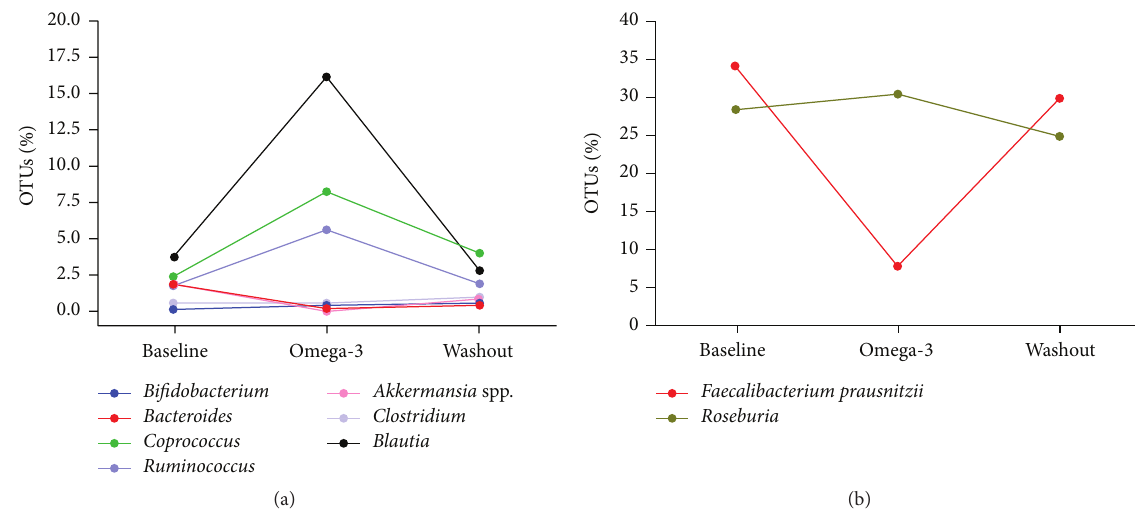
Figure 3: ((a) and (b)) Variations of the major bacterial genera in the gut microbiota at baseline, after omega-3 rich diet, and at washout. OTUs: operational taxonomic